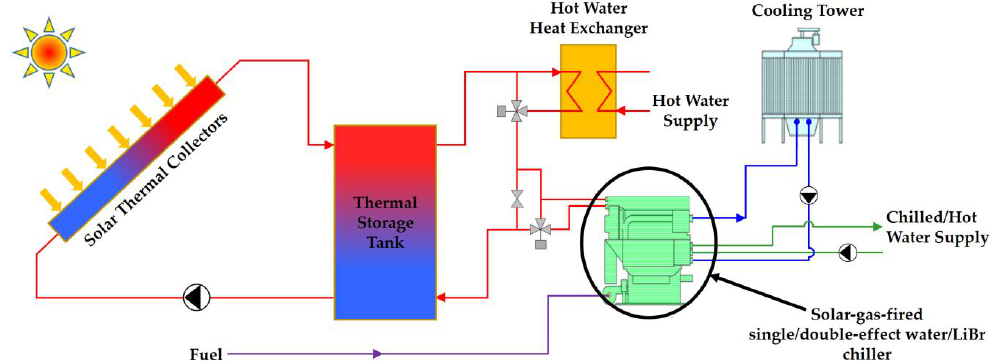
Figure 9. Solar absorption cooling system based on solar-gas-fired single/double effect absorption chiller [37,38]. Appl. Sci. 2020 , 9 , x FOR PEER REVIEW